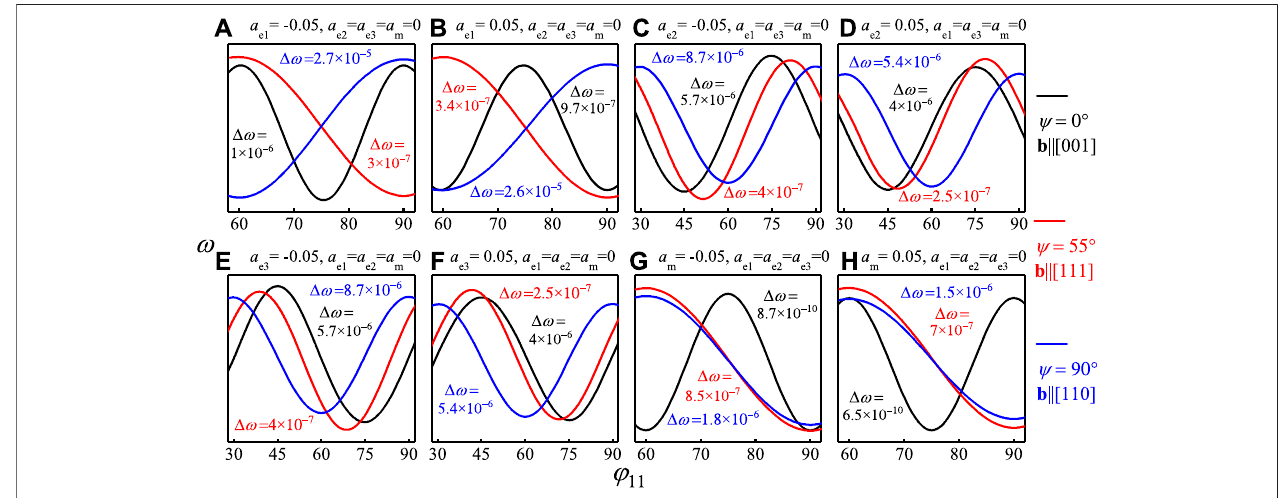
FIGURE 2 | ω as a function of φ 11 . Pinning effects of (A,B) a e1 , (C,D) a e2 , (E,F) a e3 , and (G,H) a m on SkX. The fi rst and third (second and fourth) are calculated for negative (positive) anisotropy coef fi cients. The black, red and blue curves are obtained for ψ (cid:2) 0 + [ b ||[ 001 ] ], ψ (cid:2) 55 + [ b ||[ 111 ] ] and ψ (cid:2) 90 + [ b ||[ 110 ] ], respectively. Here,inordertofacilitatecomparison,threecurveswhichdonotcorrespondtothesamey-axis,areplottedinone fi gure. Δ ω isthedifferencebetweenthemaximumand minimum of ω . The values of ω are not shown in the fi gures, they are all about − 0.1.